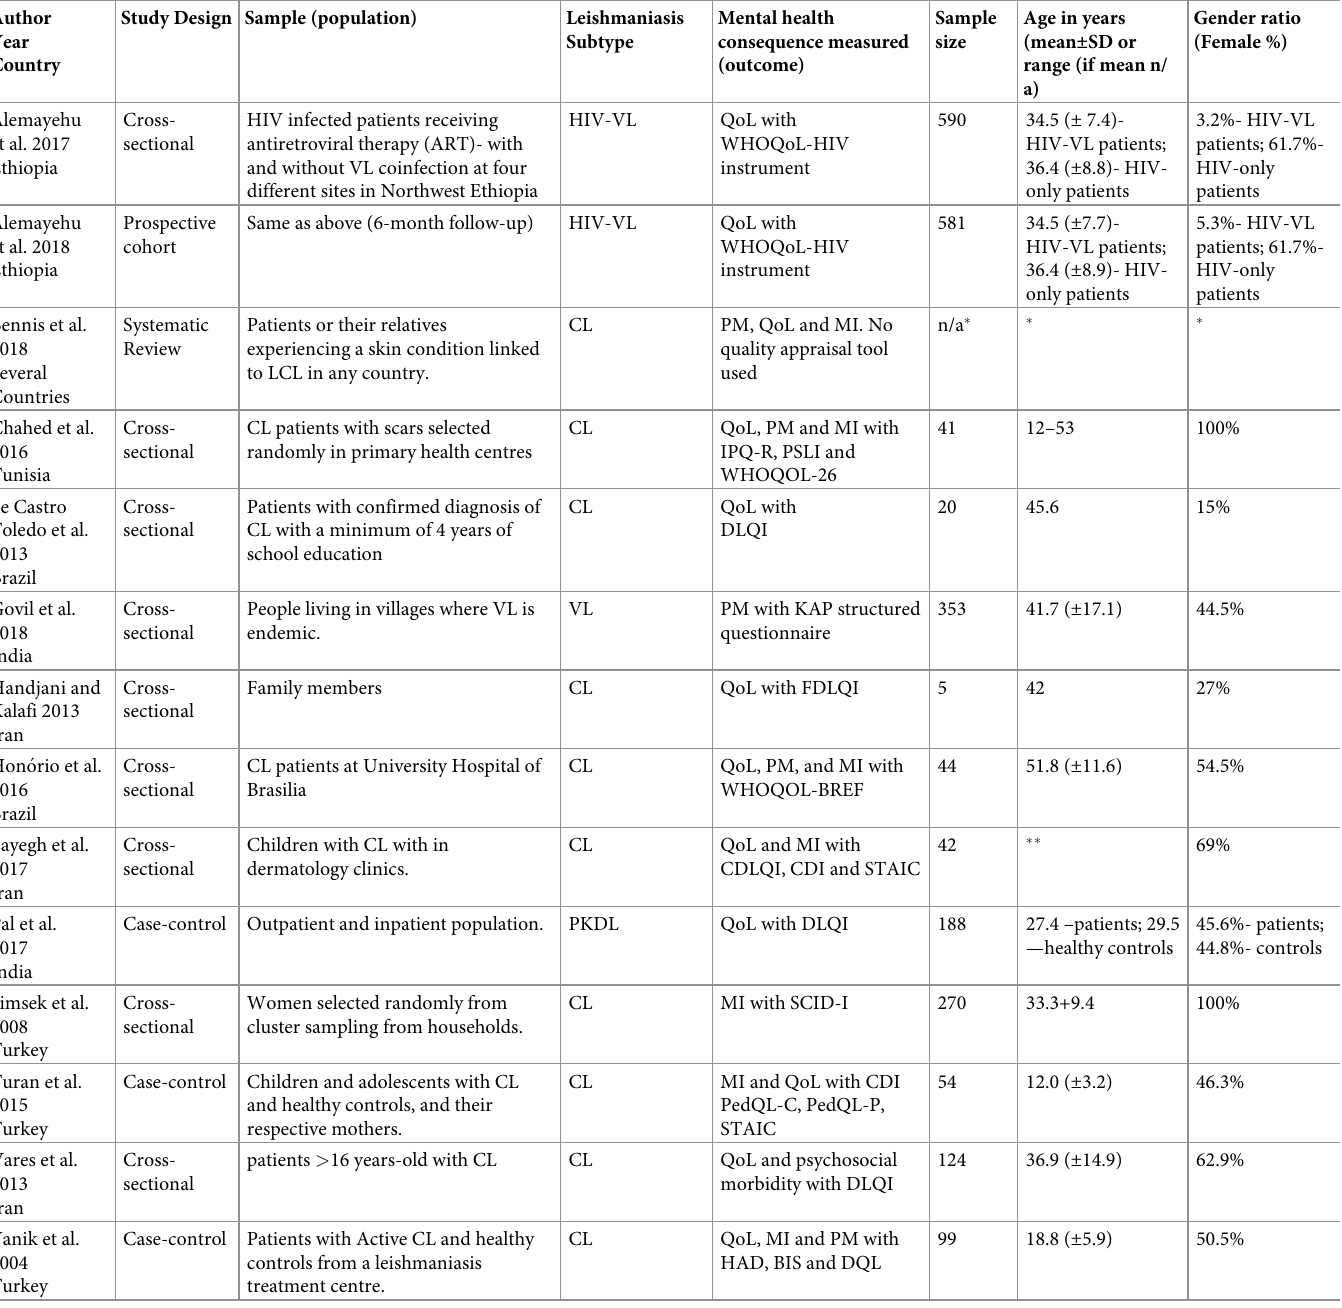
Table 1. General characteristics of the included